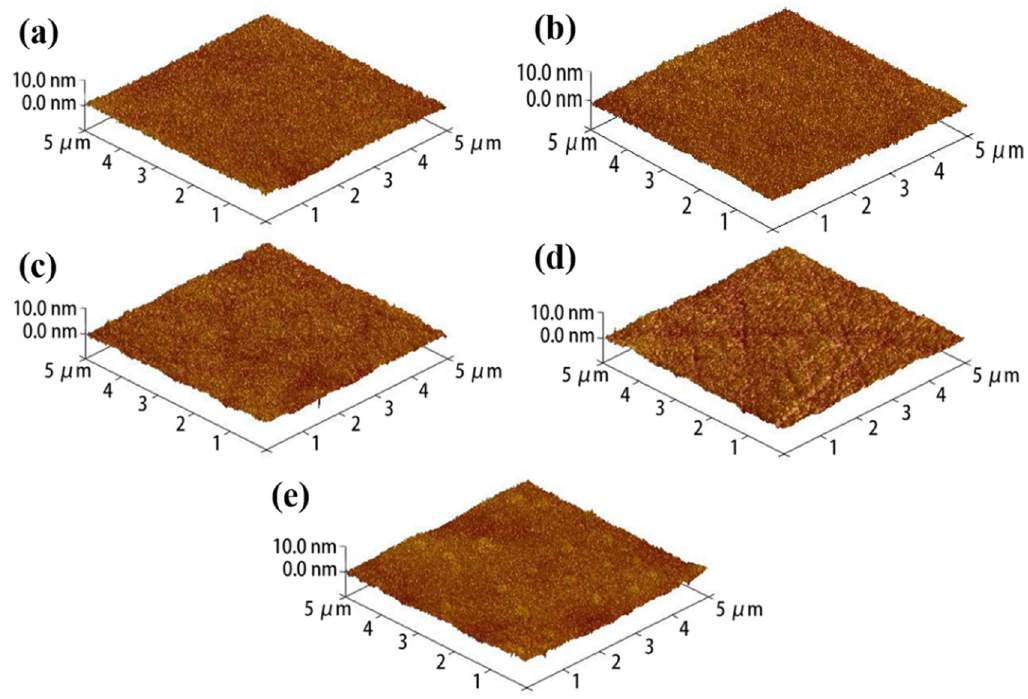
Figure 4. AFM topographies of the films ( a ) before and after annealing at ( b ) 373 K, ( c ) 423 K, ( d ) 473 K, and ( e ) 523 K.